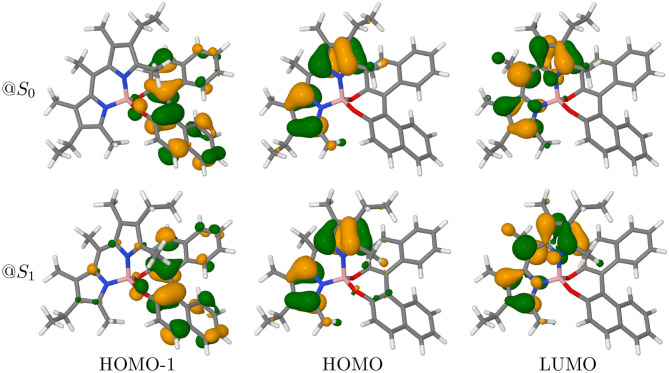
Frontiers molecular orbitals of PT conformer at S0 and S1 geometries (isodensity surfaces at ± 0.04 (e/bohr3)1/2).